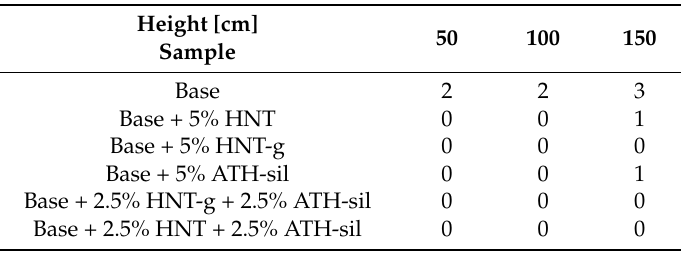
Table 3. Fall test, from a height of 50, 100, and 150 cm, of dentures with a specific composition (numerical values in each field are the average of three trials).